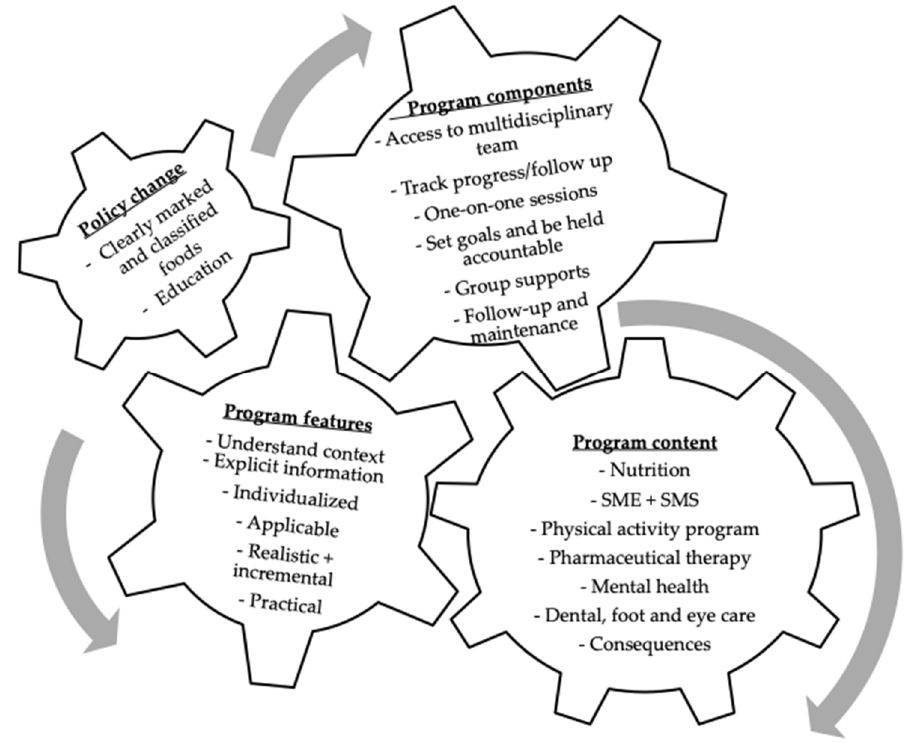
Figure 1. Program content and delivery specifications. Participants reported the information content as well as the program components and delivery mode.